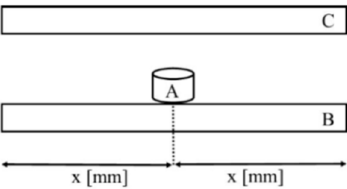
Figure 1. Compressive strength test diagram. Sample ( A ) is placed in the centre of the lower compression anvil ( B ), which is positioned in parallel to the upper compression anvil ( C ).